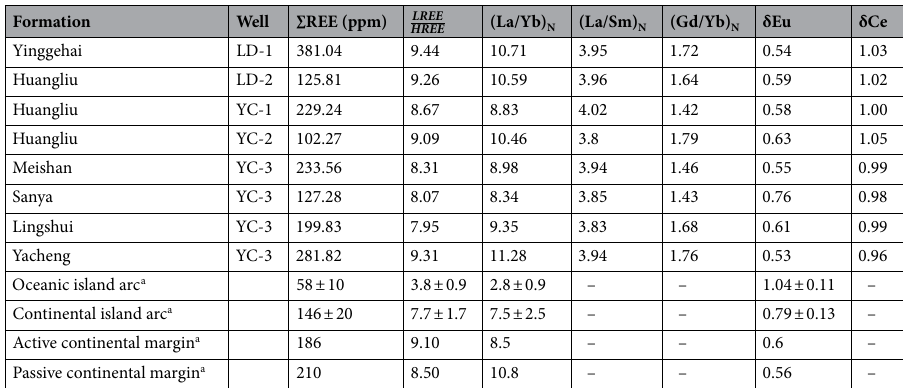
Table 2. Major rare earth elements (REE) characteristics of the Cenozoic sediments from the junction area of Yinggehai and Qiongdongnan basins. * ∑REE is the total REE content (ppm);